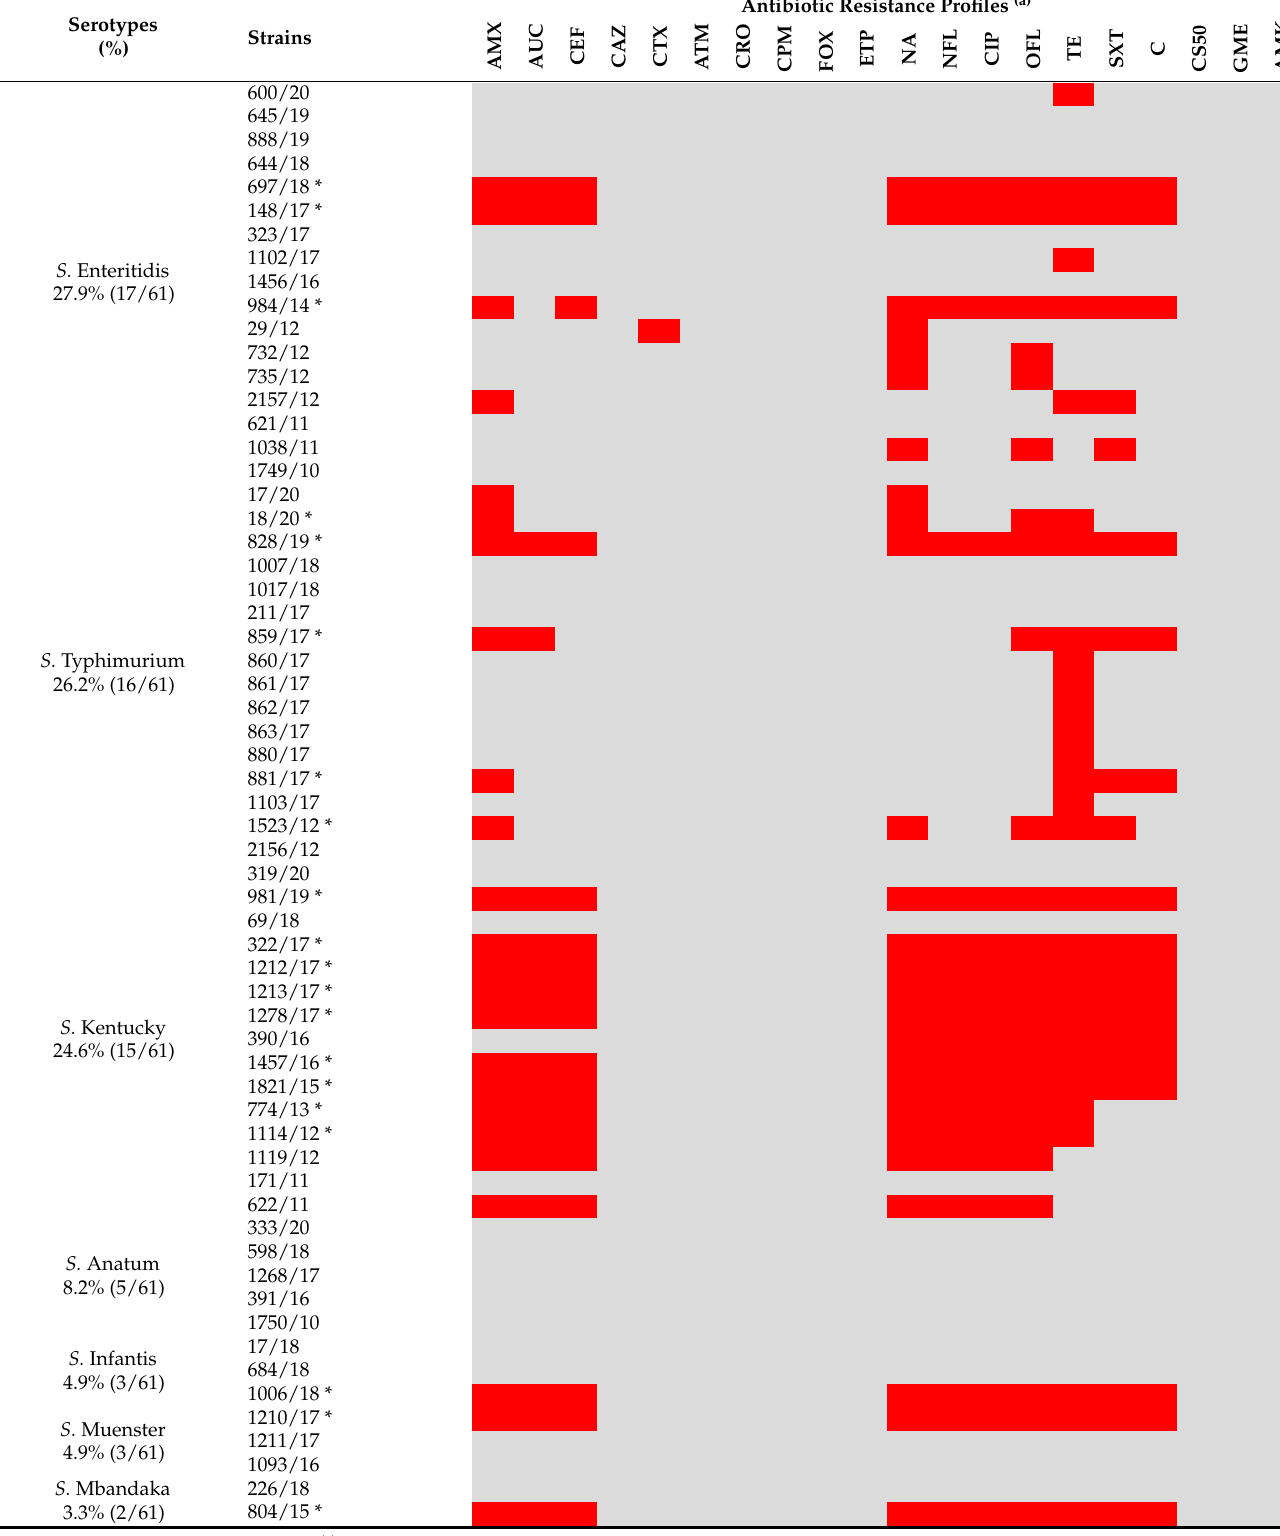
Table 2. Serotypes and antimicrobial resistance profiles of Salmonella isolated in the present study.